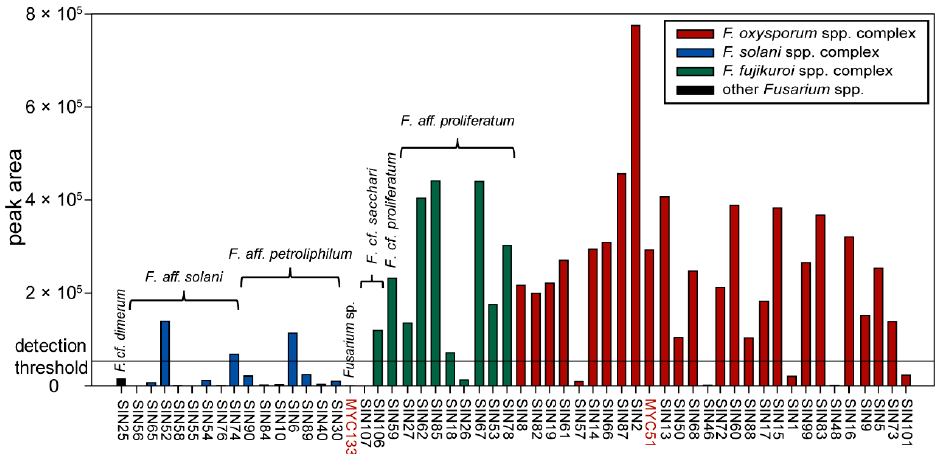
Figure 5. Prevalence of fusaric acid in Fusarium pure culture extracts. Data are grouped according to the Fusarium clades identified by phylogenetic analysis (see Figure 1). Peak area values beyond <50,000 (detection threshold adopted here) are considered as noise. All strains are of human origin, except MYC51 and MYC133 (highlighted in red). Molecules 2016 , 21 , 370